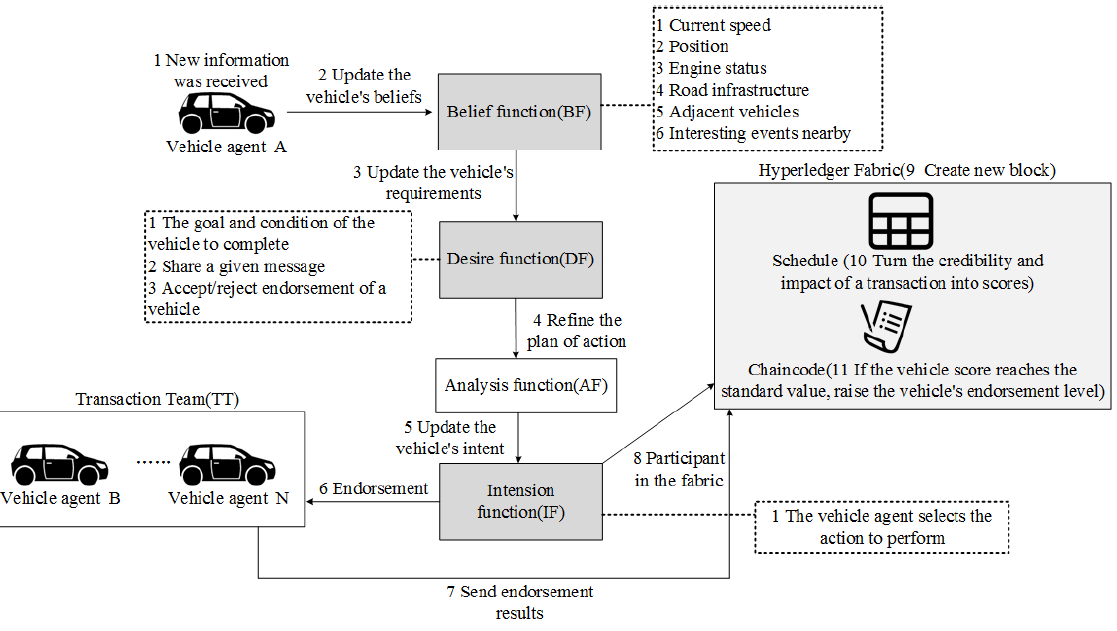
Figure 37. Reconstruction diagram of reference [69].